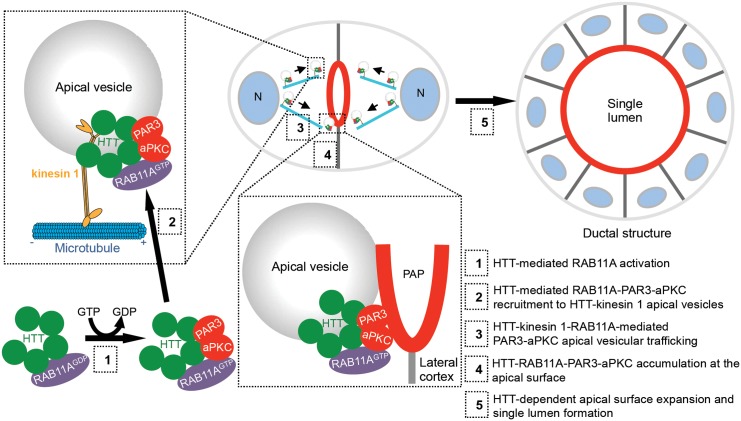
Model for HTT-mediated regulation of apical polarity.During epithelial morphogenesis, HTT modulates the activation of RAB11A (1). HTT-RAB11A forms a complex with PAR3-aPKC, which may be recruited to HTT-kinesin 1 apical vesicles (2). HTT coordinates apical recycling of PAR3-aPKC vesicles (3). PAR3-aPKC accumulation at the pre-apical patches (PAP) (4) triggers the expansion of the apical membrane, leading to the formation of a central lumen (5).